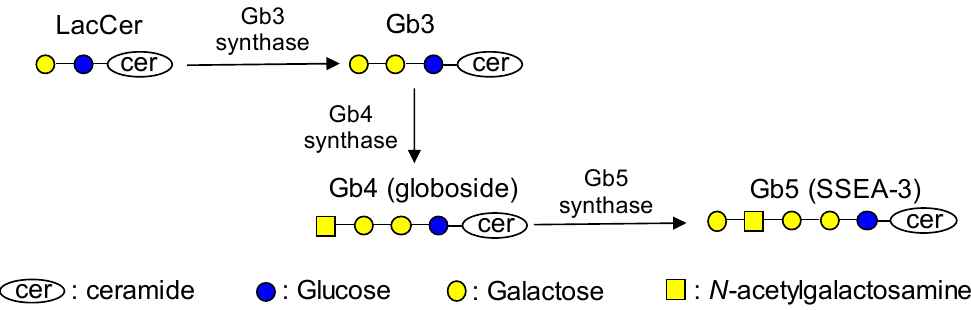
Figure 1. Synthetic pathway of globo-series glycosphingolipids.